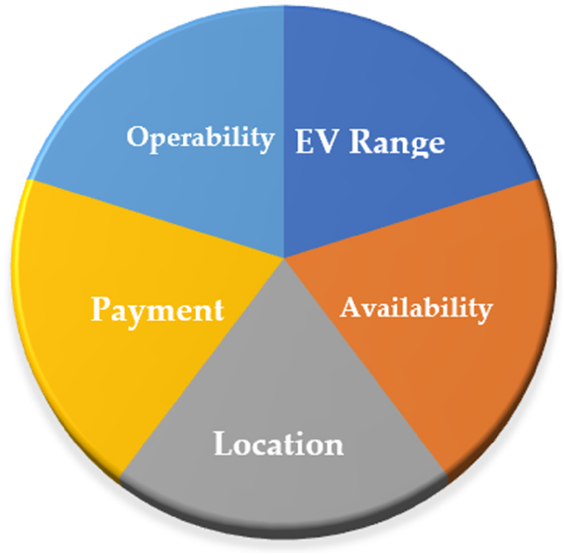
Figure 1. Significant concerns discouraging drivers from purchasing an EV [9].